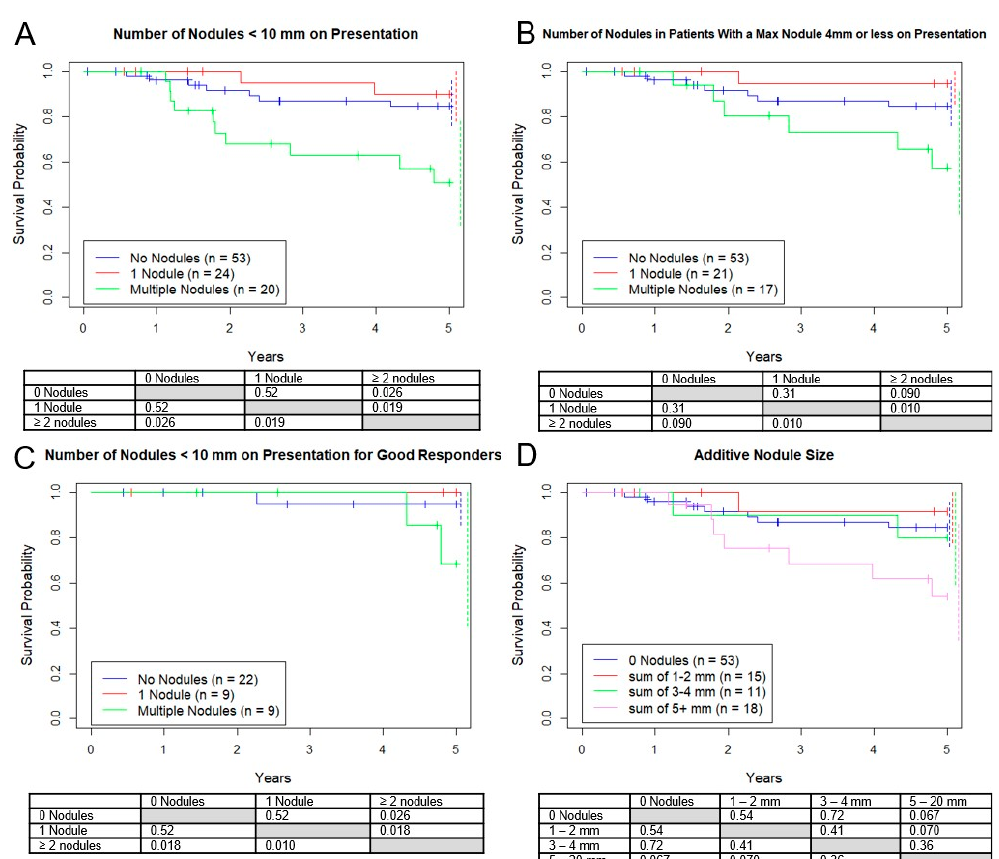
Figure 4. Kaplan–Meier curves demonstrating survival probability vs. years. Groups separated by ( A ) number of nodules, ( B ) number of nodules <5 mm, ( C ) number of nodules <10 mm restricted to “good responders”, or ( D ) sum of diameter. Dotted lines represent 95% confidence intervals for respective color.